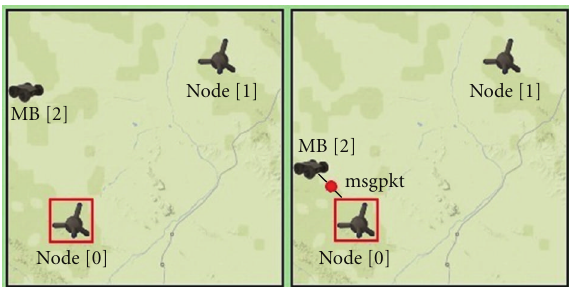
Figure 8: Network topology—mobile UGV and fixed